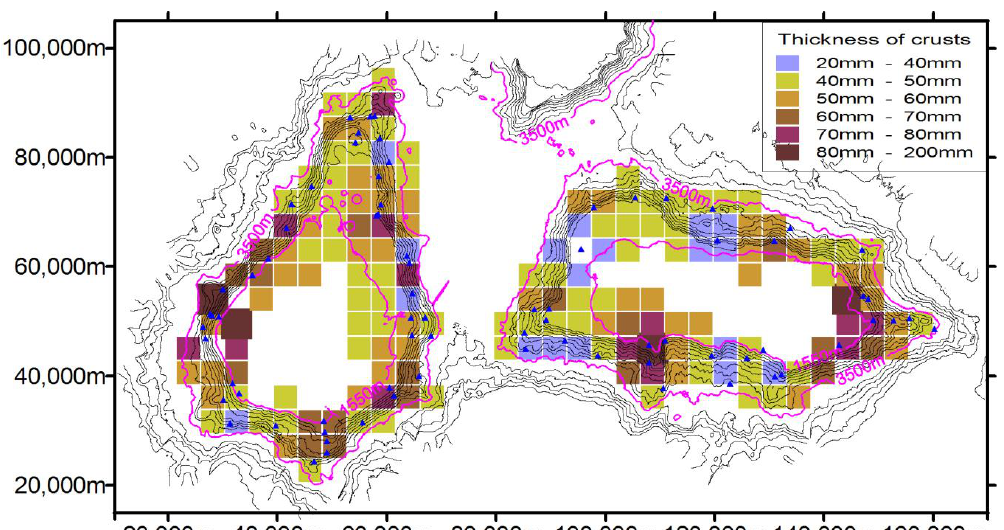
Figure 7. Distribution of cobalt-rich crust thicknesses estimated using the proposed method. The triangles in blue are the sample locations that are surveyed; almost all the samples locate the bathymetry contour interval at 1500 m to 3500 m. This indicates that the values estimated by the kriging for grid cells in this interval should be considered.